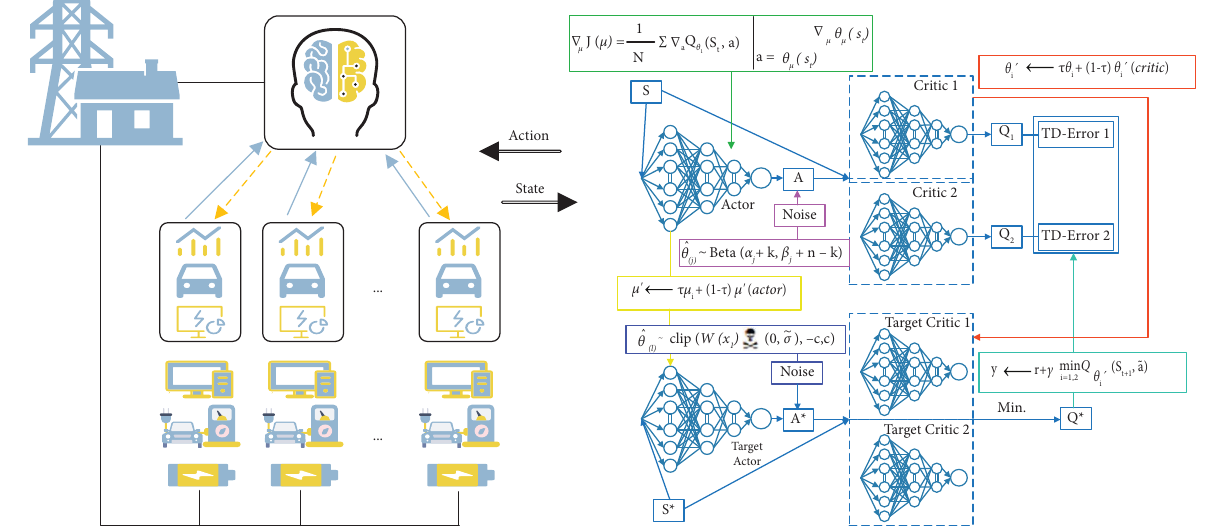
Figure 3: Management framework for CSMS based on the improved TD3. Table 2: Pseudocode of proposed Improved TD3 algorithm. Pseudocode of improved TD3 algorithm for sales price and energy